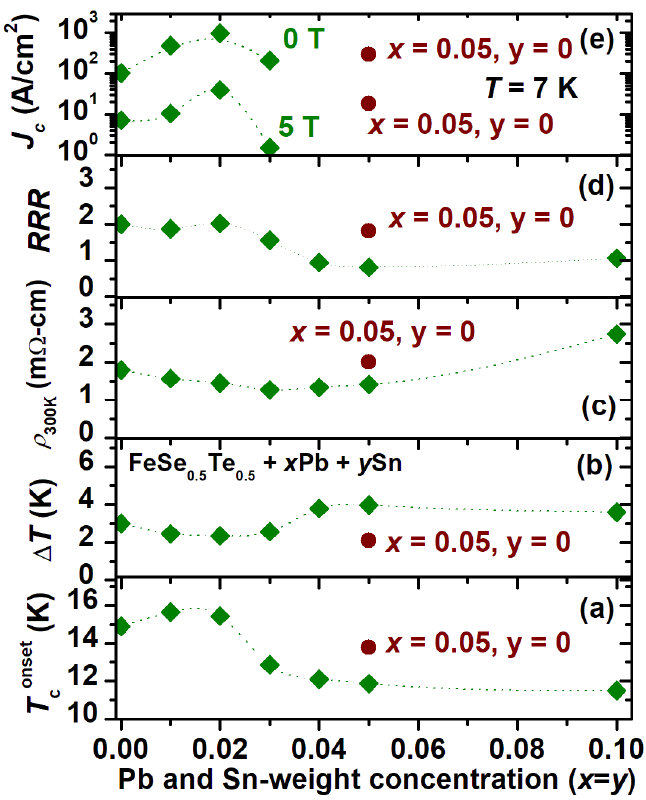
Figure 6. The variation of ( a ) transition temperature ( T c ), ( b ) transition width ( Δ T ), ( c ) room temperature resistivity ρ 300K , ( d ) residual resistivity ratio RRR ( ρ 300K / ρ 20K ) and ( e ) the critical current density J c for 0 T and 5 T at 7 K with respect to weight% of Pb and Sn addition for parent FeSe 0.5 Te 0.5 , i.e., FeSe 0.5 Te 0.5 + x Pb + y Sn ( x = y = 0, 0.01, 0.02, 0.03, 0.04, 0.05, and 0.1) and also only Pb-added FeSe 0.5 Te 0.5 ( x = 0.05, y = 0).